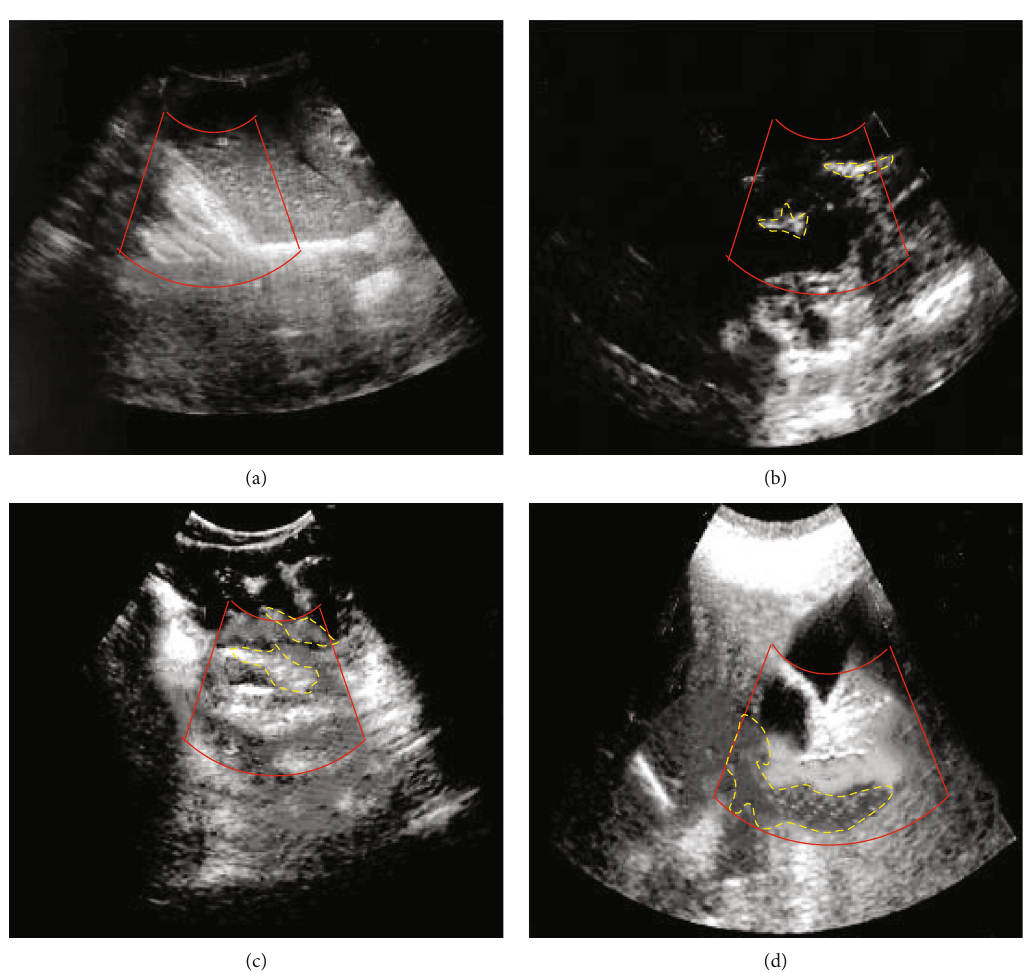
Figure 2: Ultrasound images corresponding to each grade of scoring. (a): 0 point; (b): 1 point; (c): 3 points; (d): 4 points. Table 1: Basic data of patients in the two